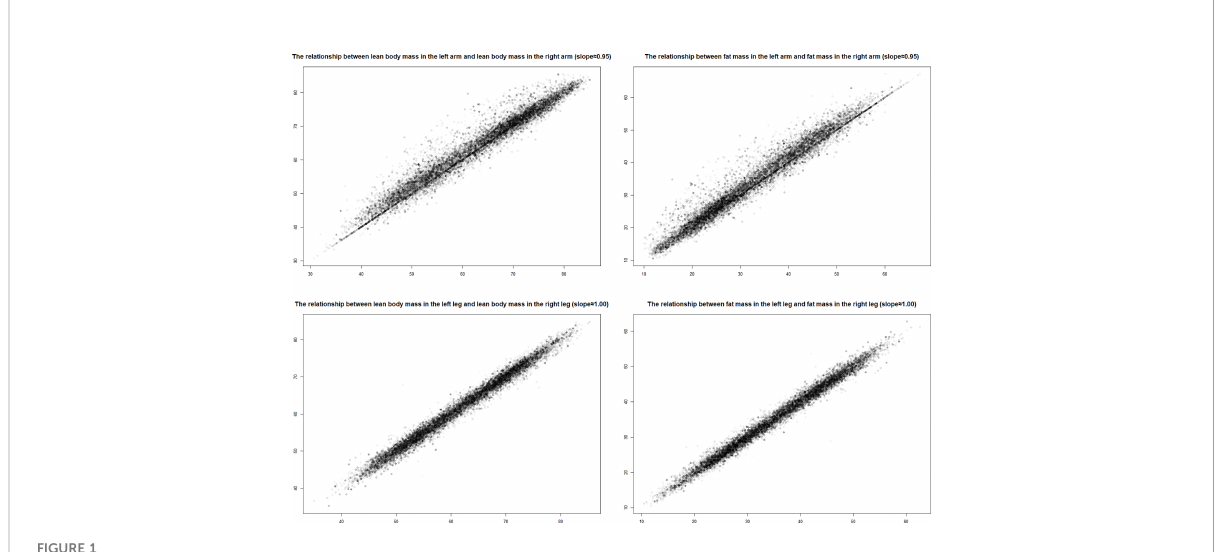
FIGURE 1 Lean mass and body fat percentage in left and